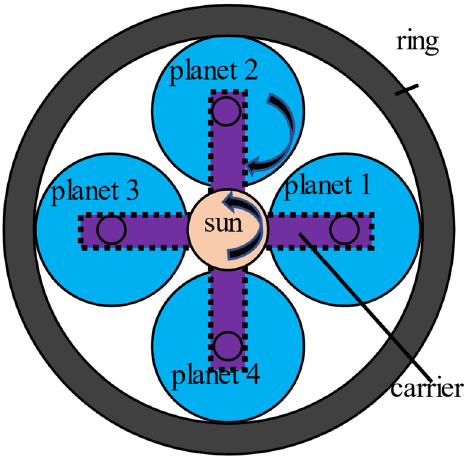
Figure 8. Planetary gearbox with four planet gears.